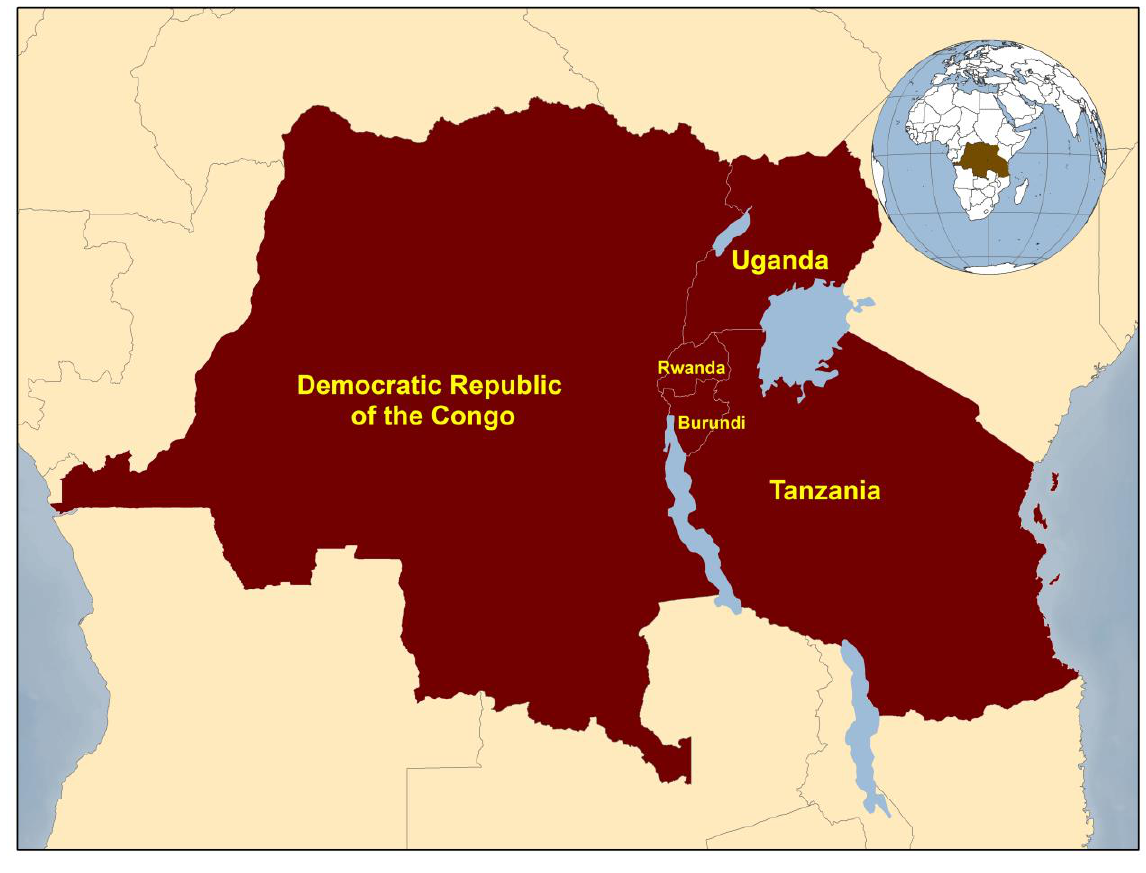
Figure 1: Location of the Democratic Republic of Congo, Burundi, Rwanda, Tanzania, and